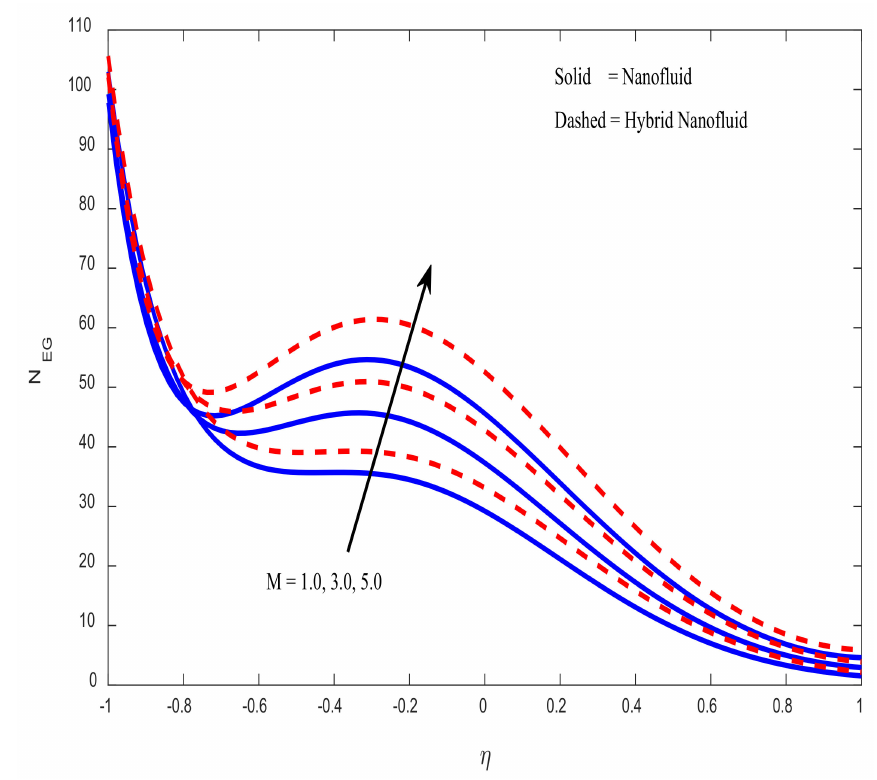
Figure 18. Influence of M on entropy generation profile.